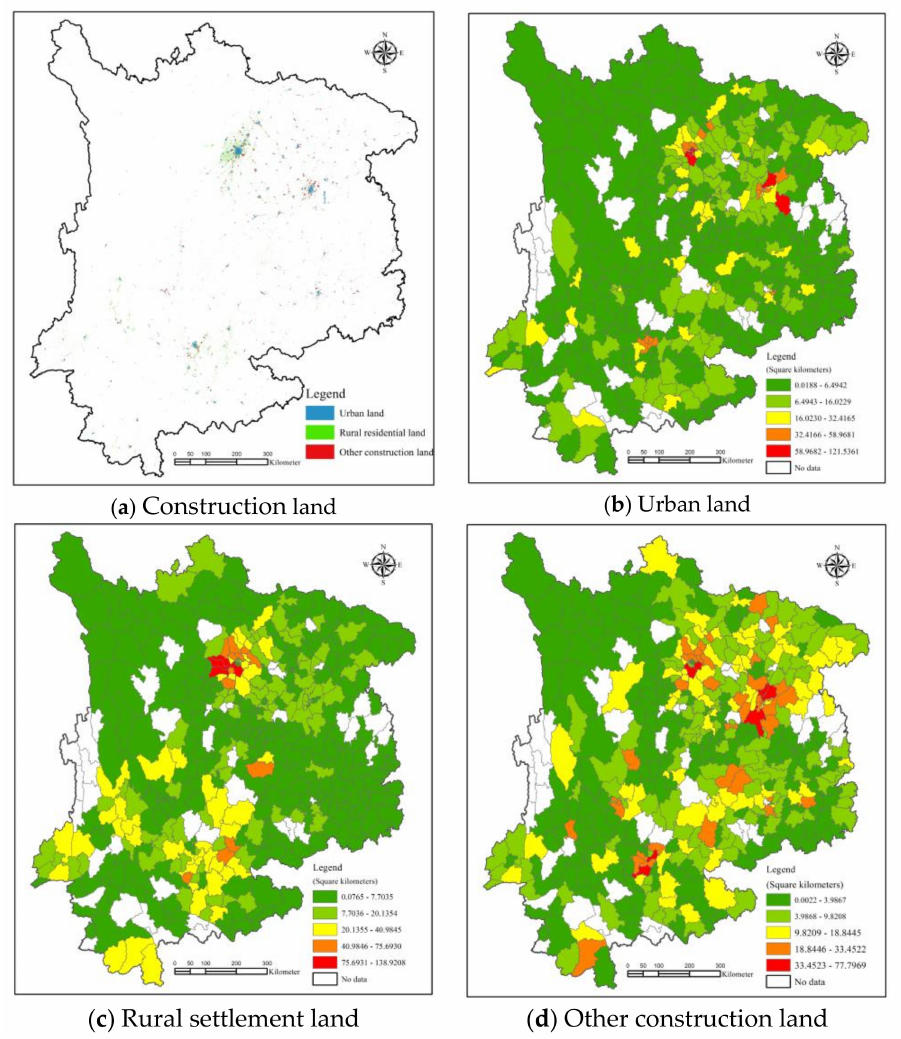
Figure 4. Spatial differences of different types of construction land in Southwest